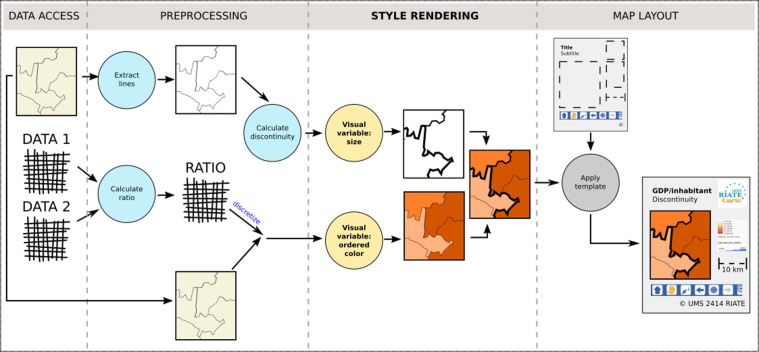
The four stages of the cartographic map design, inspired from Nicolas & Christine (2013).